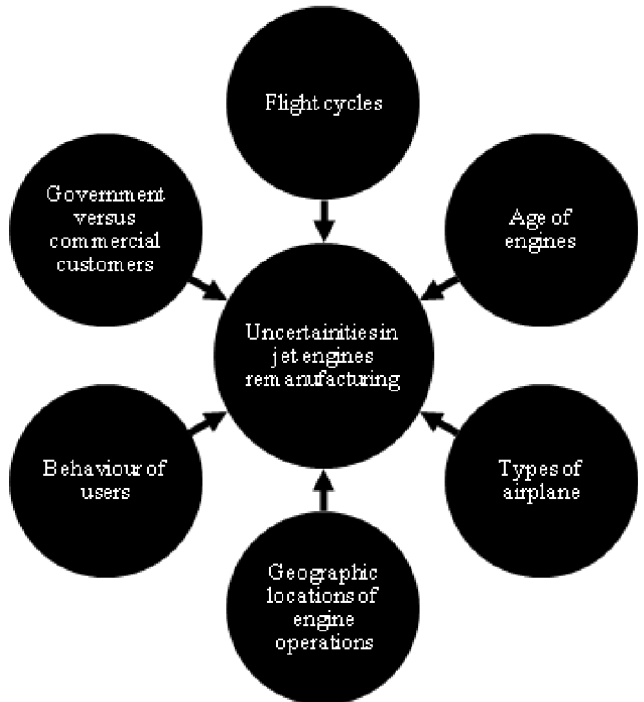
Figure 3. Sources of uncertainty in jet engine